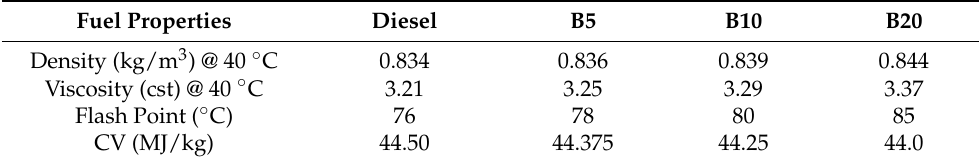
Table 4. Fuel properties of the fuel used.